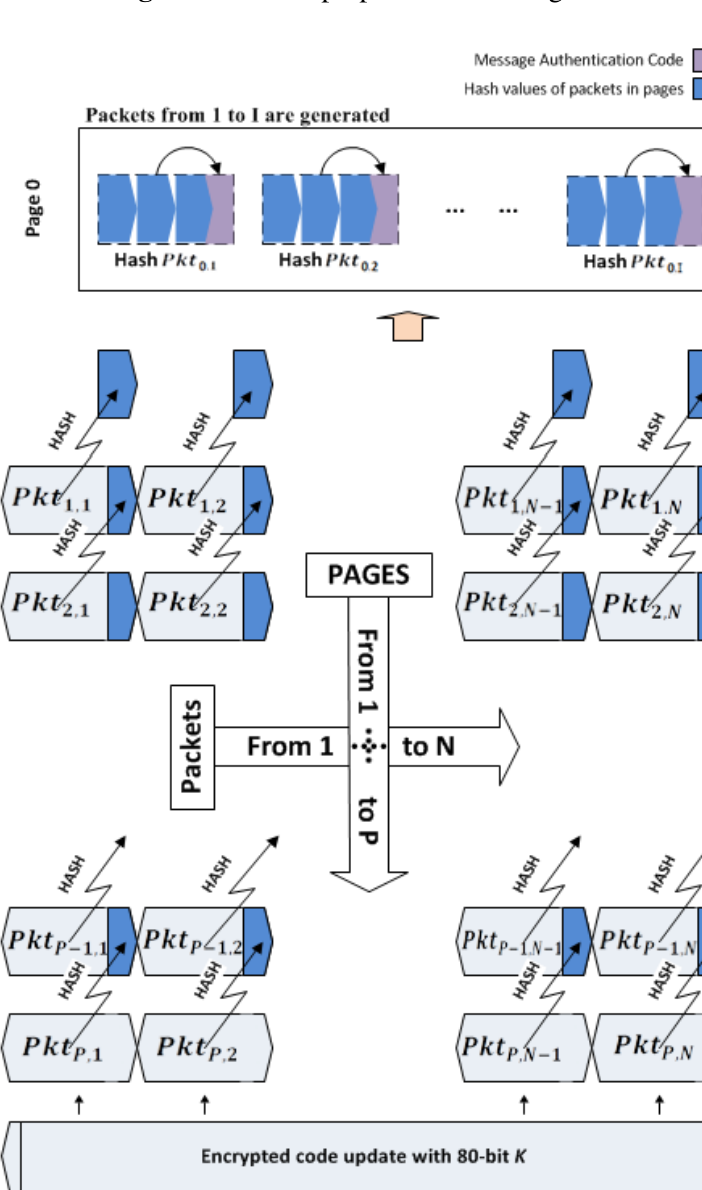
Figure 7. Packet preparation in